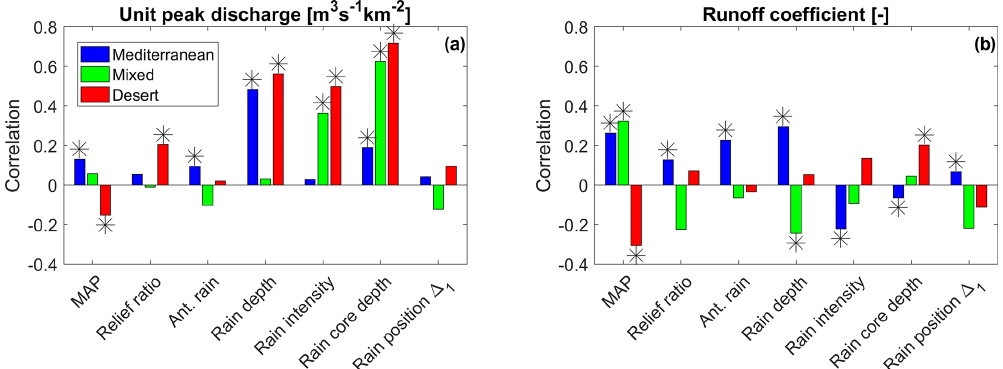
Figure 6. Pearson correlations between unit peak discharge and other parameters among floods of different regions. The asterisks indicate statistically significant correlations (Wilcoxon test, p value < 0 .